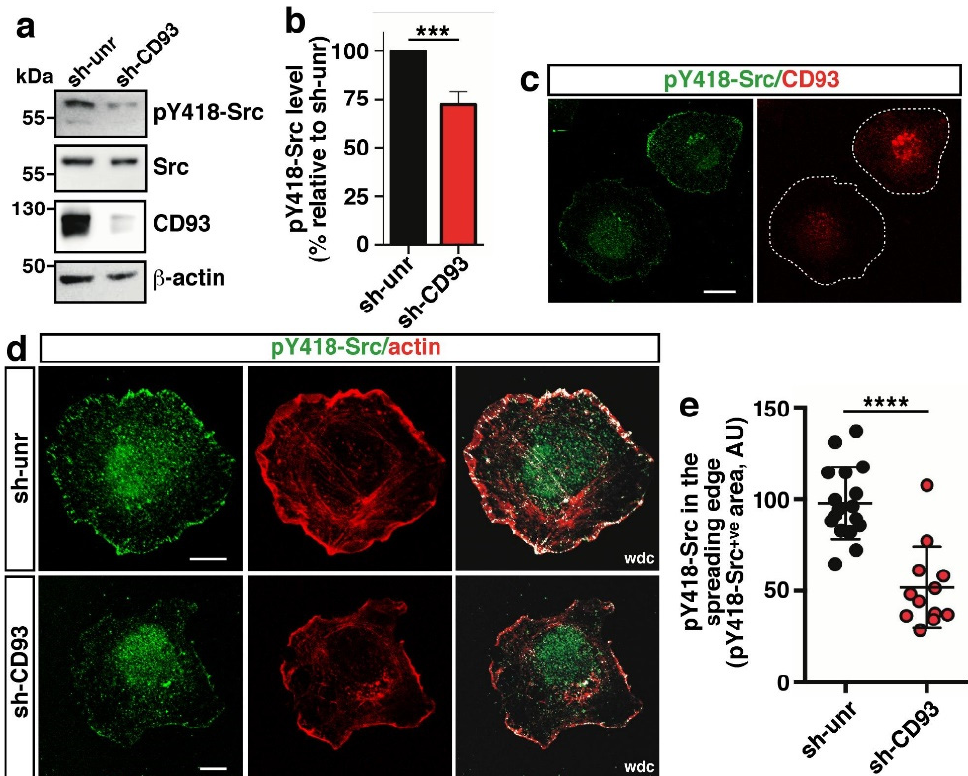
Figure 1. CD93 regulates the activation of Src in adhering ECs. HUVECs were transduced with lentiviral particles expressing unrelated (sh-unr) or CD93 (sh-CD93) shRNAs. ( a ) Total cell extracts from early spreading transduced HUVECs were analyzed by Western blotting with antibodies against pY418-Src, Src, and CD93. Anti- β -actin antibodies were used to confirm equal loading. ( b ) Quantitative analysis of pY418-Src levels from independent experiments performed as in ( a ). Values, normalized to total Src and β -actin protein levels, represent the percentage of Src phosphorylation in CD93-silenced cells (sh-CD93) relative to control (sh-unr). *** p < 0.001; paired t -test. ( c ) Transduced HUVECs were detached from the plate by a non-enzymatic method, resuspended in complete medium, mixed, reseeded, and fixed at the early phases of spreading. Cells were stained using antibodies against pY418-Src and CD93. White dashed lines indicate cell boundaries. Scale bar, 20 µ m. ( d ) Representative images of immunofluorescence analysis of transduced ECs in the early phase of adhesion. Cells were stained using phalloidin and antibodies against pY418-Src. White dot colocalization (wdc) images between pY418-Src and F-actin are shown. Scale bar, 10 µ m. ( e ) Quantification of cellular pY418-Src in the spreading border area (5 µ m from the cell edge) of control cells ( n = 17, sh-unr) and CD93-silenced cells ( n = 12, sh-CD93). Data are presented as a scatter plot, and the fluorescence intensity of the pY418-Src +ve signal per area is reported as arbitrary units (AU). **** p < 0.0001; Mann–Whitney test.